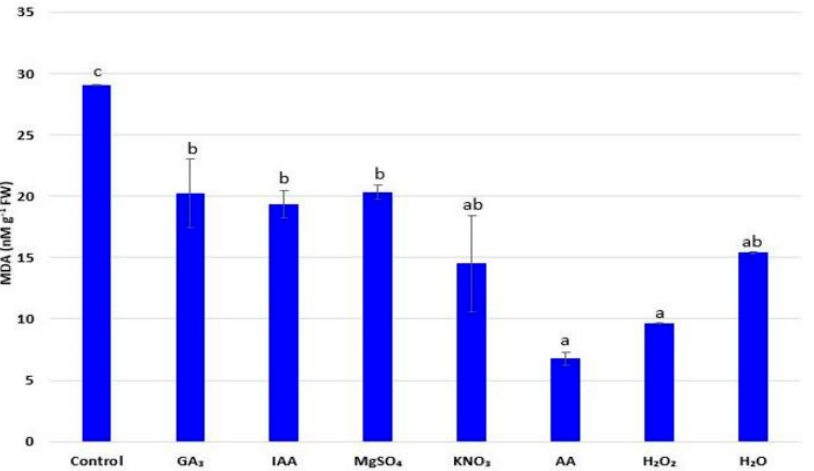
Figure 3. Influence of different priming treatments on malondialdehyde (MDA) content in leaves of radish ( R. sativus ) seedlings; the values represent the means of six replicates ± standard error. Different letters indicate significant differences ( p ≤ 0.05) between treatments according to Tukey’s test.